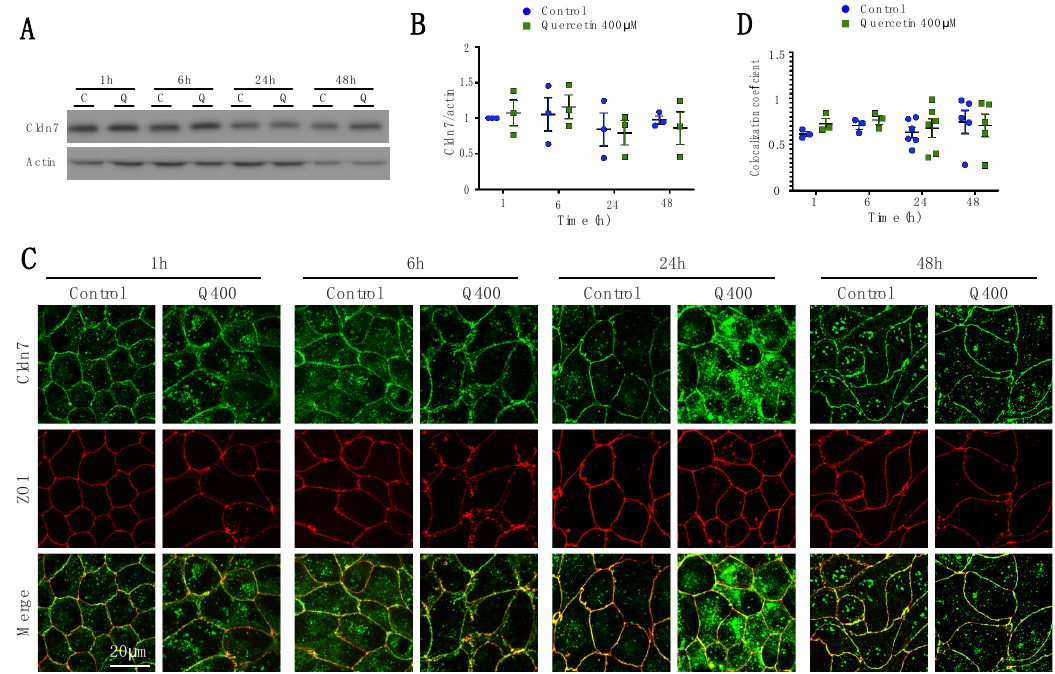
Figure 6. Analysis of Cldn7 expression and localization in MDCK II cells following quercetin treatment. ( A ) Western blot analysis of Cldn7 expression in cell lysates from control and 400 µ M quercetin-treated MDCK II cells. Actin was used as a loading control. ( B ) Densitometry measurements of Cldn7 and actin intensity on western blot were normalized to control at 1h. Normalized Cldn7 expression relative to normalized actin is plotted (P int = 0.916; P time = 0.41; P treat = 0.98). ( C ) Immunofluorescence of control and 400 µ M of quercetin-treated MDCK II cells at 1, 6, 24, and 48 h. Cldn7 is shown in green and ZO1 is shown in red. ( D ) Localization of claudin at the tight junction was assessed by determining the amount of ZO1 that co-localized with claudin expression (P int = 0.89; P time = 0.8; P treat = 0.55). For all graphs each point corresponds to an independent experiment; mean and SEM are shown. C = Control and Q = Quercetin. Scale bar, 20 µm.